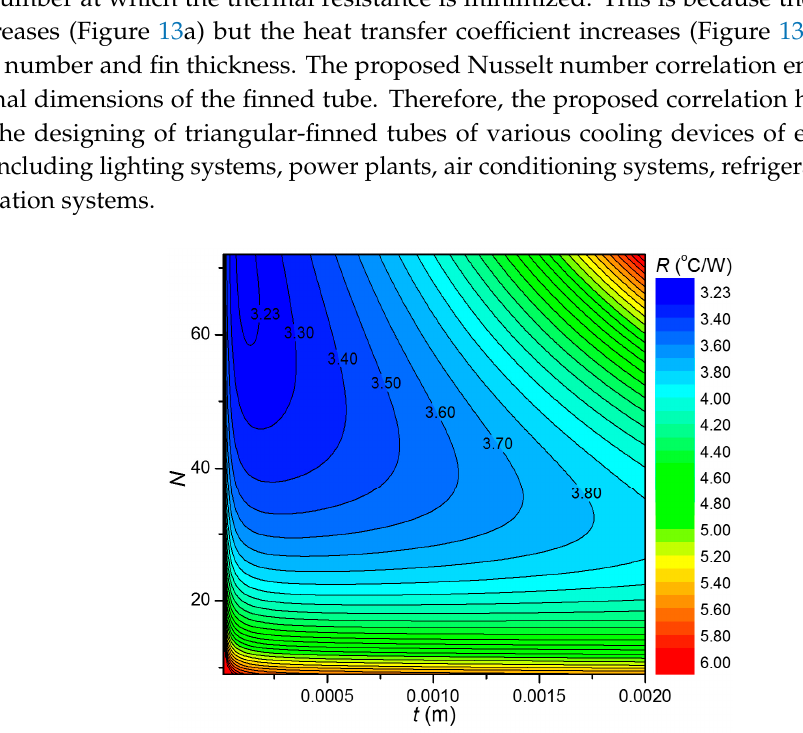
Figure 11. Effects of fin height on effective surface area, heat transfer coefficient, and thermal resistance.